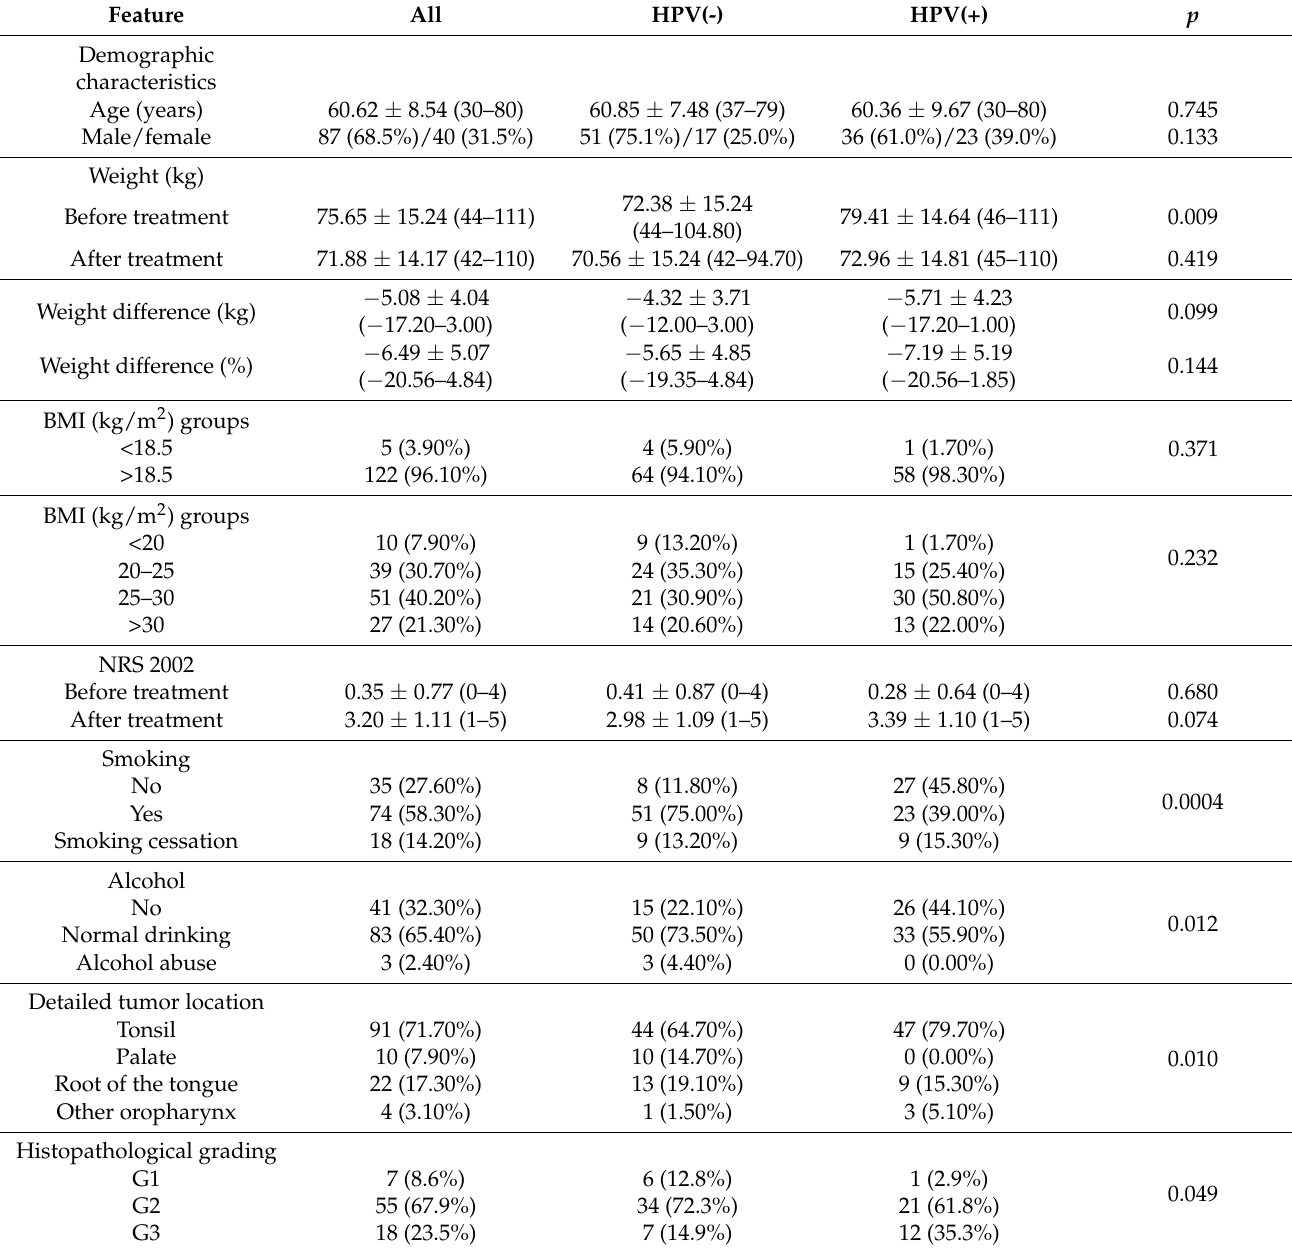
Table 1. The patients’ general clinicopathological characteristics and basic laboratory